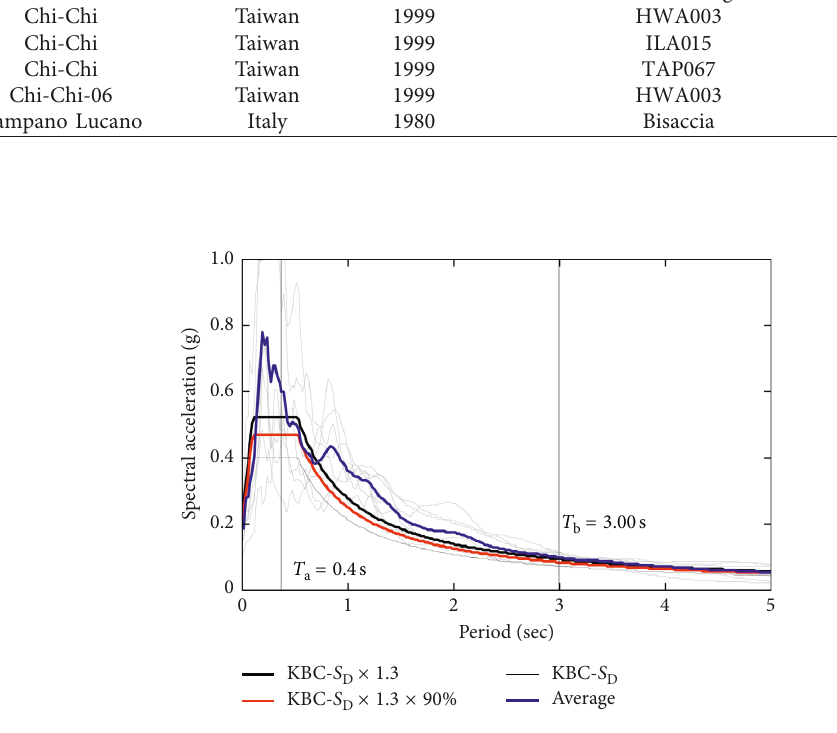
Figure 11: Frequency contents of used earthquakes